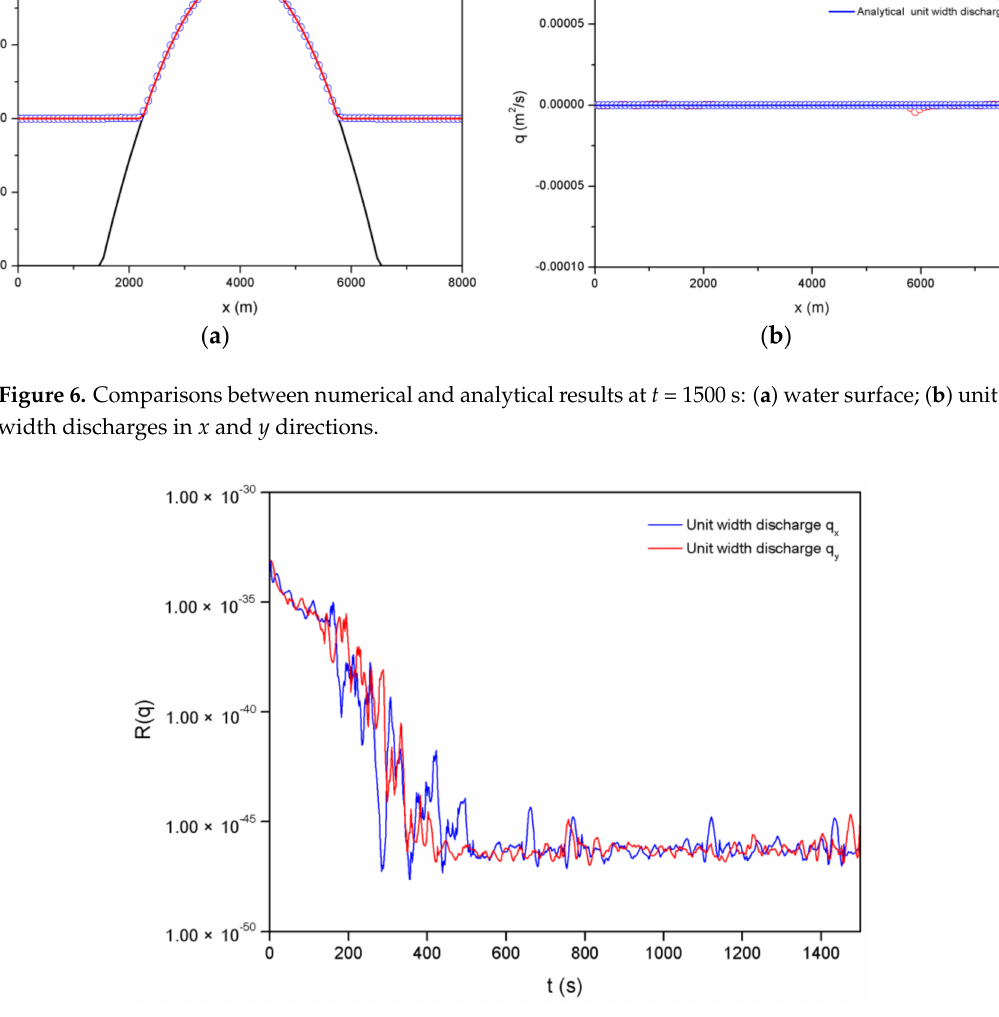
Figure 7. Global relative errors of unit width discharges in x and y